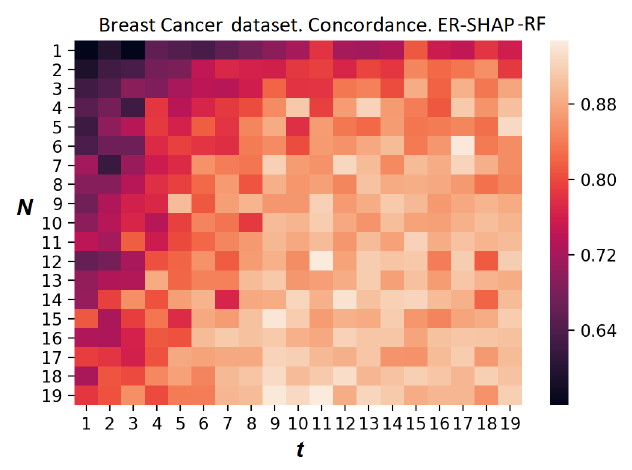
Figure 27. The heatmap reflecting the concordance index C obtained by ER-SHAP-RF for the Breast Cancer dataset without using the temperature